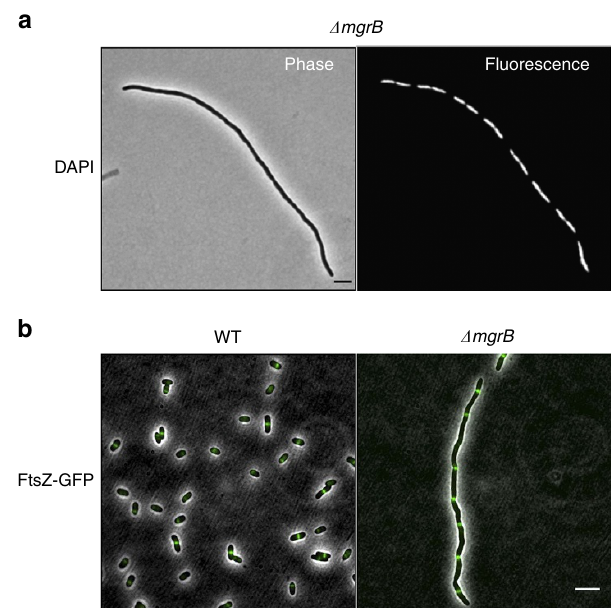
Figure 3 | Chromosomal segregation and FtsZ ring formation are not impaired in filamenting cells. ( a ) Phase contrast and fluorescence micrographs of D mgrB (AML20) cells stained with DAPI. ( b ) Fluorescence micrographs of wild-type E. coli (EC448) and D mgrB (JNC19) cells showing FtsZ-GFP localization. All cultures were grown in minimal medium with no added Mg 2 þ . Scale bar, 5 m